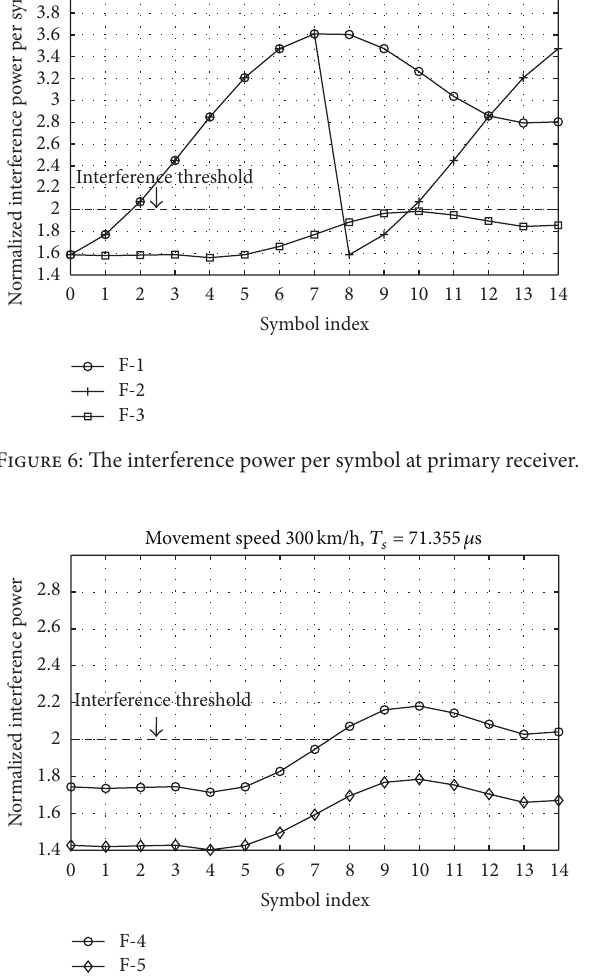
interference constraints are impacted by 𝜌 2 , the performance of the interference constraint is related to the change of the channel correlation coefficient. The value of 𝜌 2 will decrease from 1 to 0 in the first 9 symbols and then increase from the 10th symbol. Therefore, as shown in Figure 6, the trend of the interference power has the convex and wavy features. The traditional IC constraint with quasistatic varying channel. The interference constraint cannot ensure the interference power under threshold after 2 symbols,